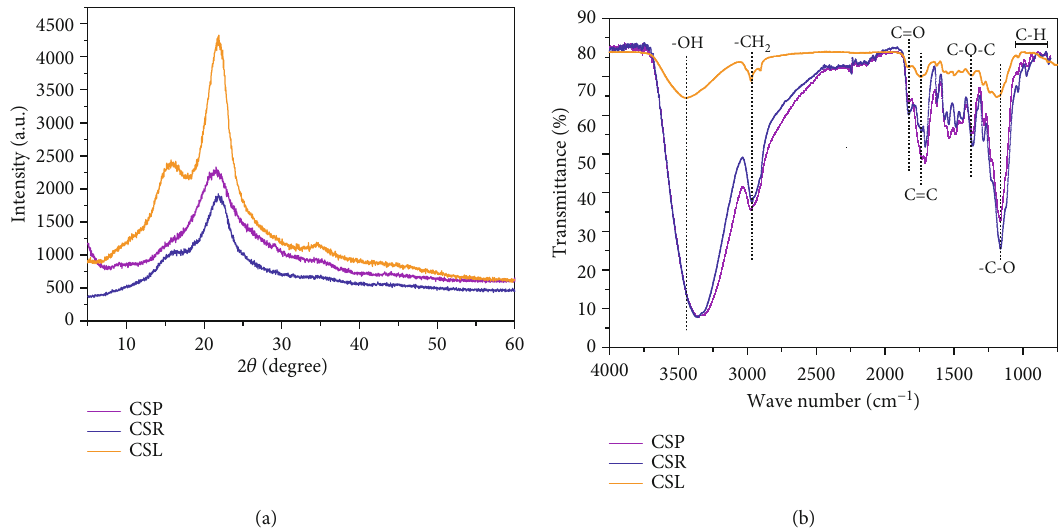
Figure 4: XRD (a) and FTIR (b) spectra of corn stover pith, rind, and leaf.